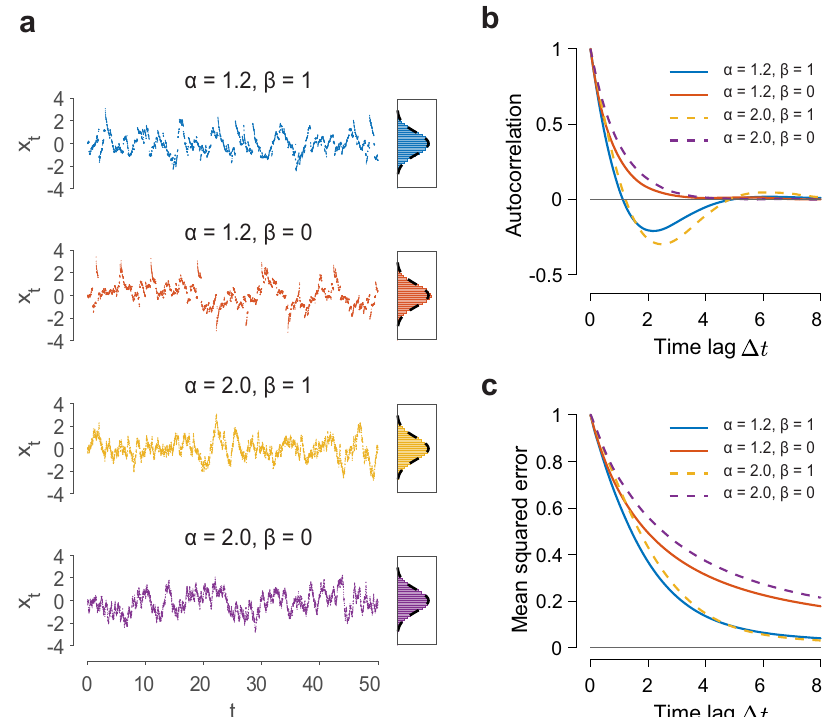
exhibitanoscillatorycomponent. c Meansquarederrorasafunctionof Δ t .Thetwo caseswithanoscillatorycomponent( β =1)havesigni fi